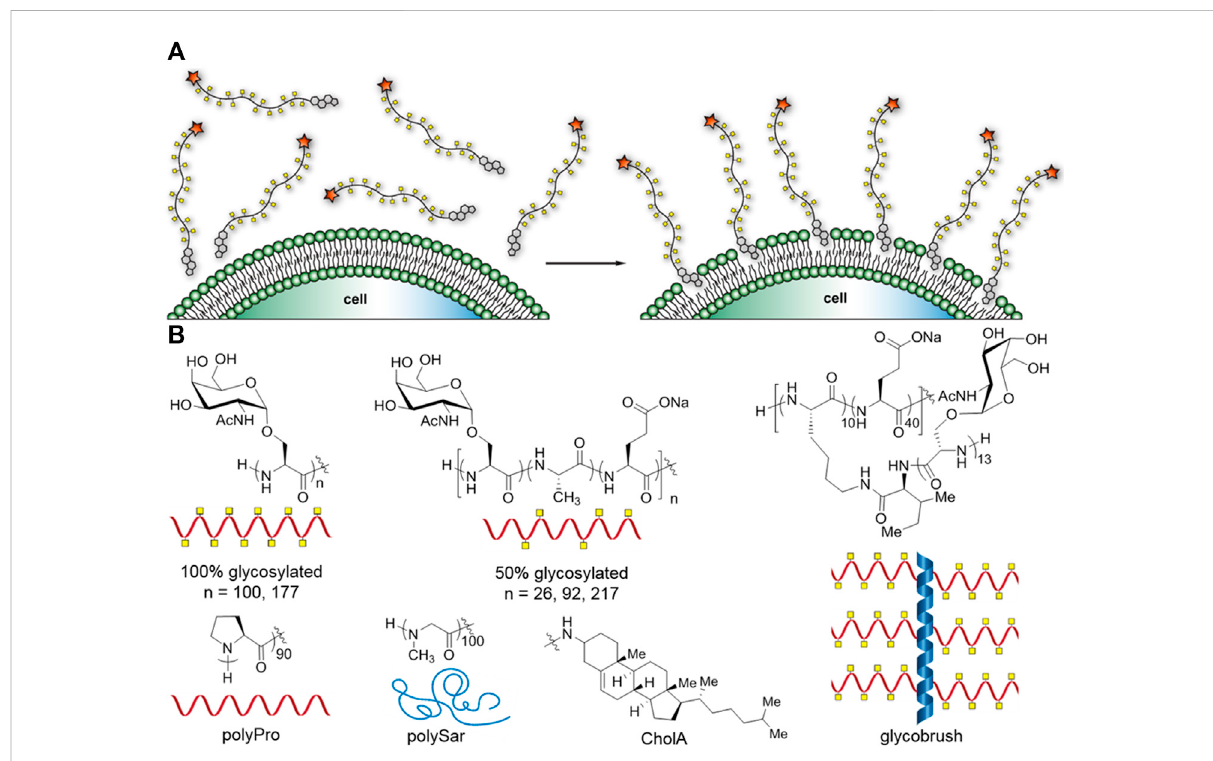
FIGURE 1 Cartoon representation of the glycocalyx engineering method and synthetic mucin panel. (A) Glycocalyx engineering by insertion of cholesterylamide-terminalsynMUCsintothemembranesoflivecells. (B) ChemicalstructuresandcartoonrepresentationsofsynMUCpanelusedin this study, and chemical structure of cholesterylamide (CholA) hydrophobic